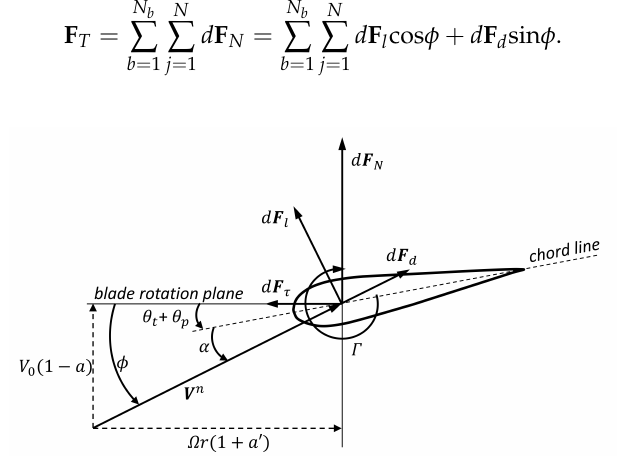
Figure 5. Forces acting on a blade